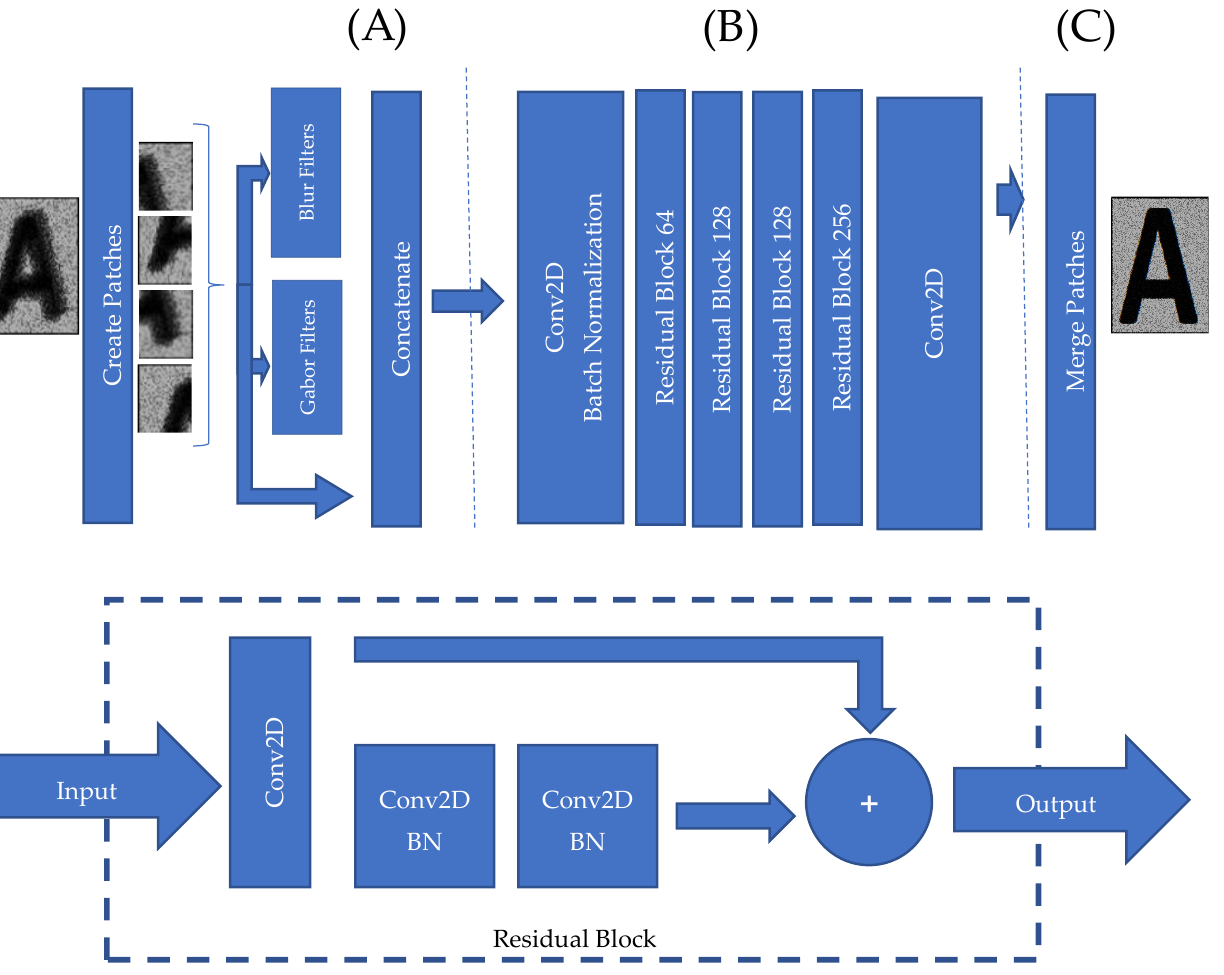
Figure 5. The Gabor filter effect on the input image. The left image is input image and right image is Gabor filter with kernel size 5. The value of theta (rotation angle) changes from 0 to 180 by 30